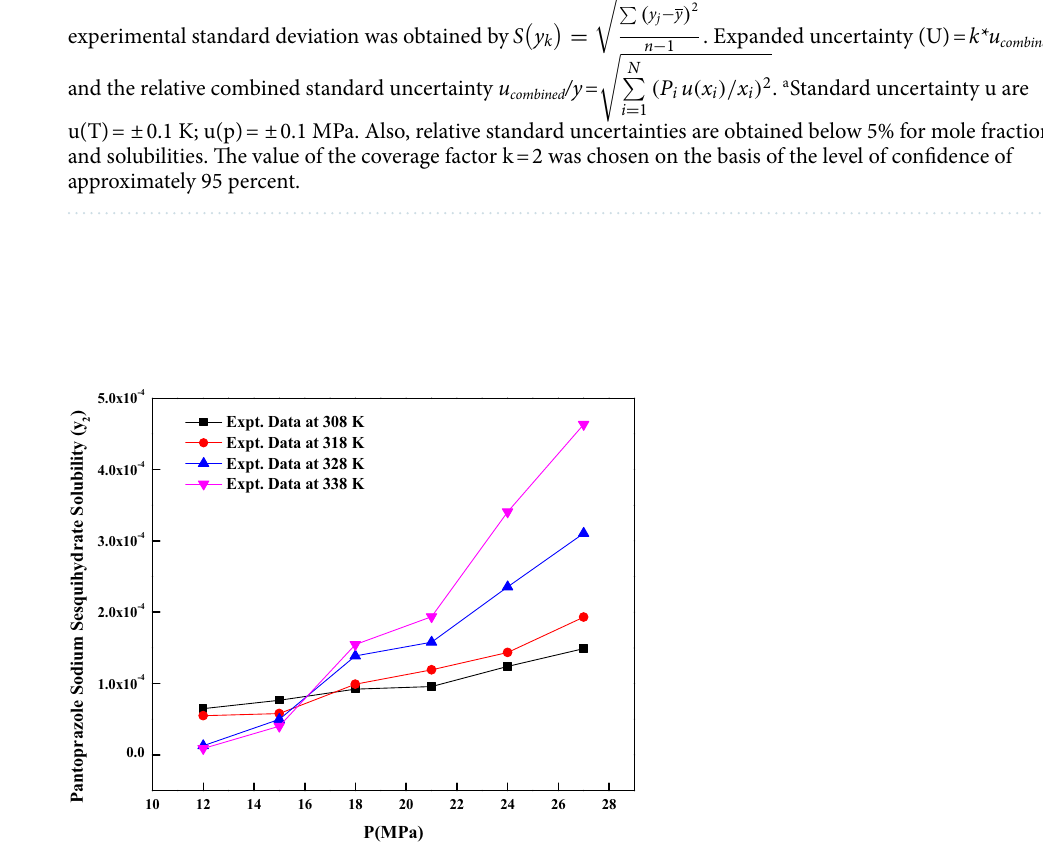
Figure 2. Pantoprazole sodium sesquihydrate solubility vs.